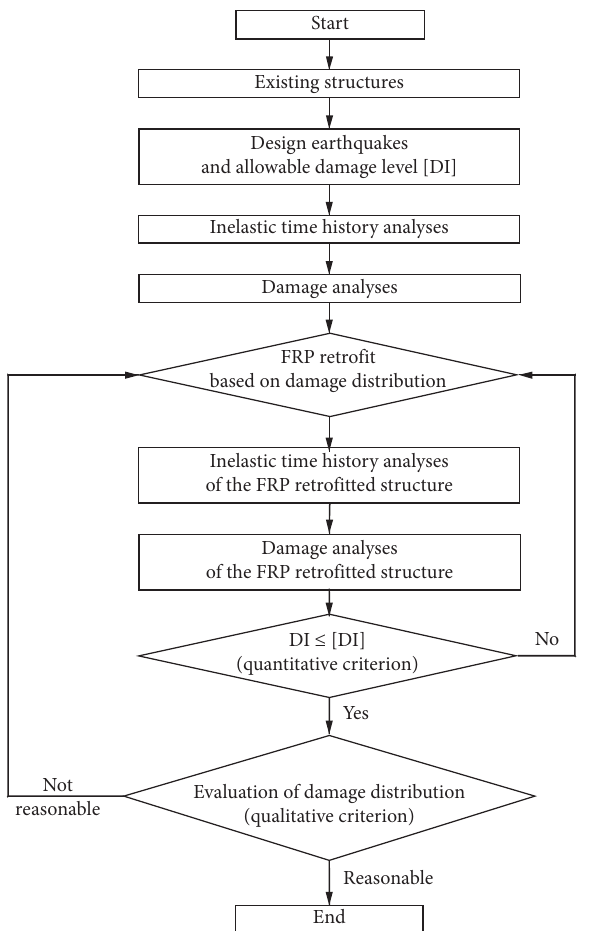
Figure 1: The proposed damage-based FRP retrofitting